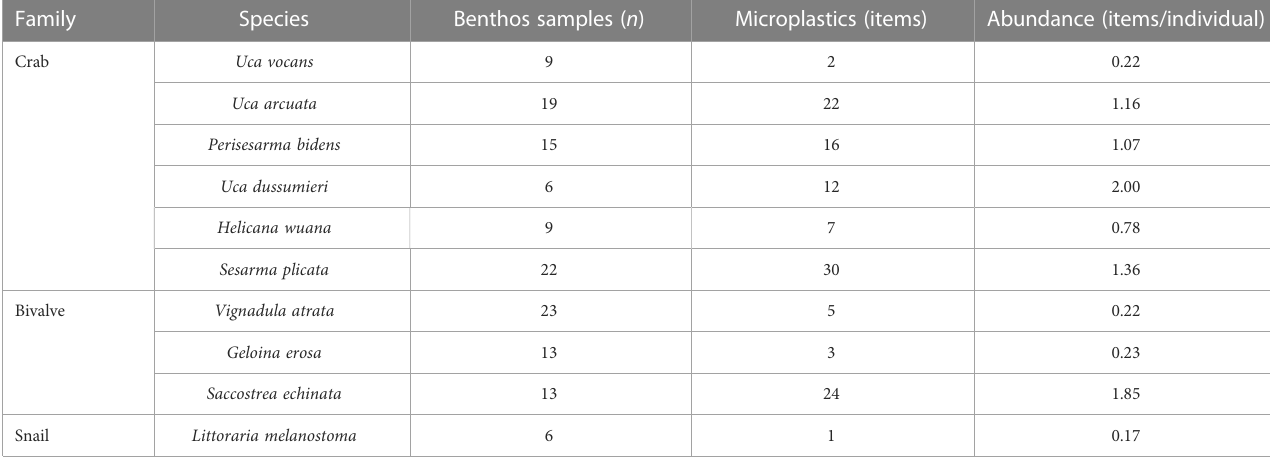
TABLE 1 Abundance of microplastics in different benthic species.